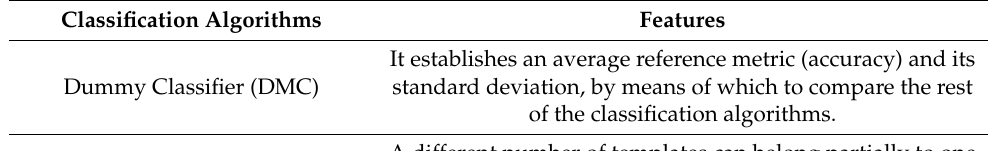
Table 9. Classification algorithms and their